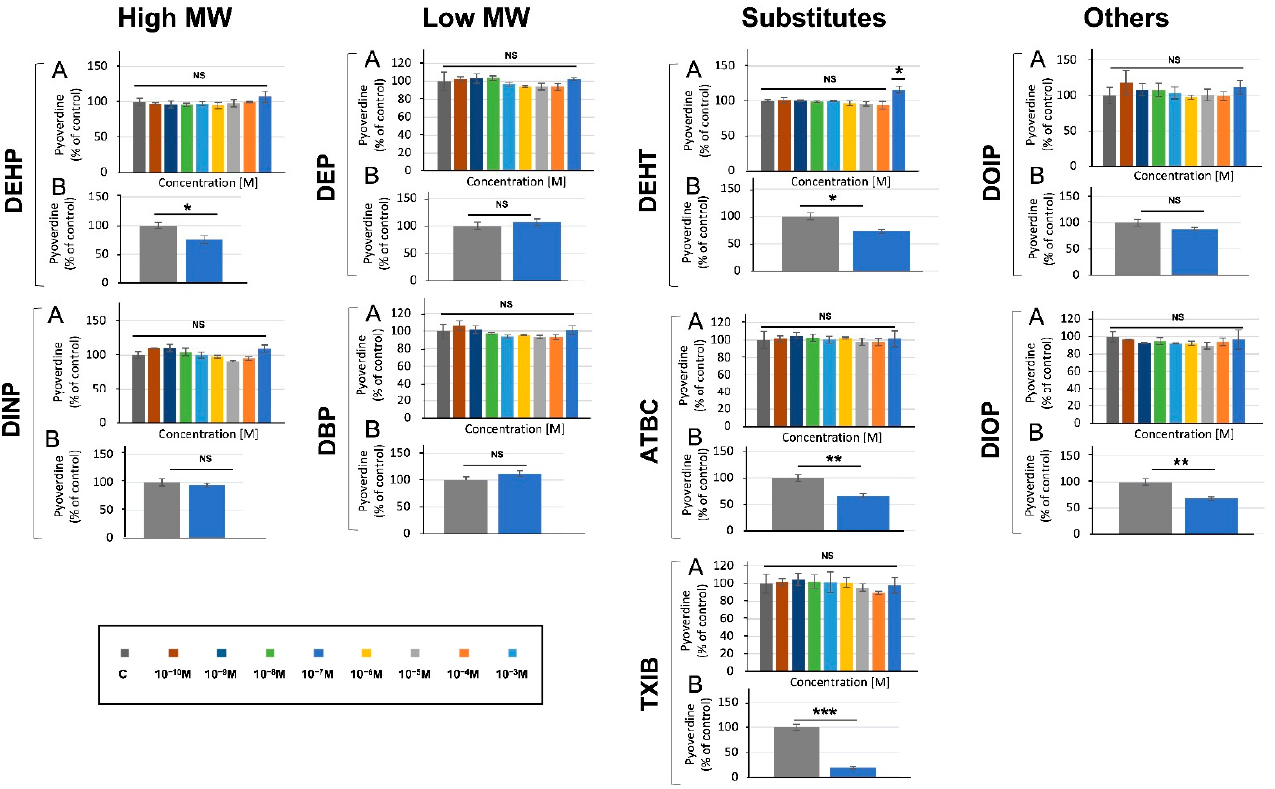
Figure 4. Effect of phthalates and substitutes on pyoverdine production when P. aeruginosa was grown in microtiter plates ( A ) or in Erlenmeyer flasks ( B ). Phthalate and substitute concentrations ranging from 10 − 3 to 10 − 10 M (colors indicated in the scale). GC: P. aeruginosa ’s growth control inM9 succinate medium without any phthalates or substitutes. NS = p > 0.05; * = p < 0.05; ** = p < 0.01; *** = p < 0.001.